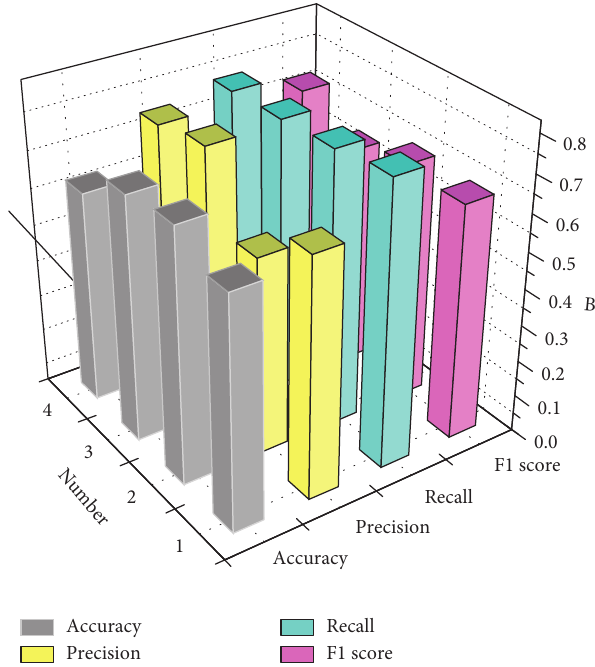
Figure 6: Classification based on social security financial